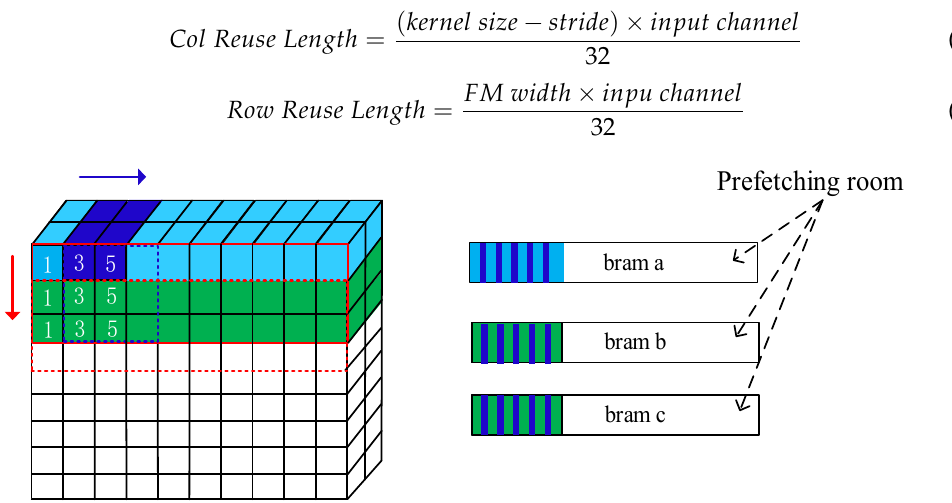
Figure 9. Schematic diagram of spatial reuse and the three-path cache queue design.